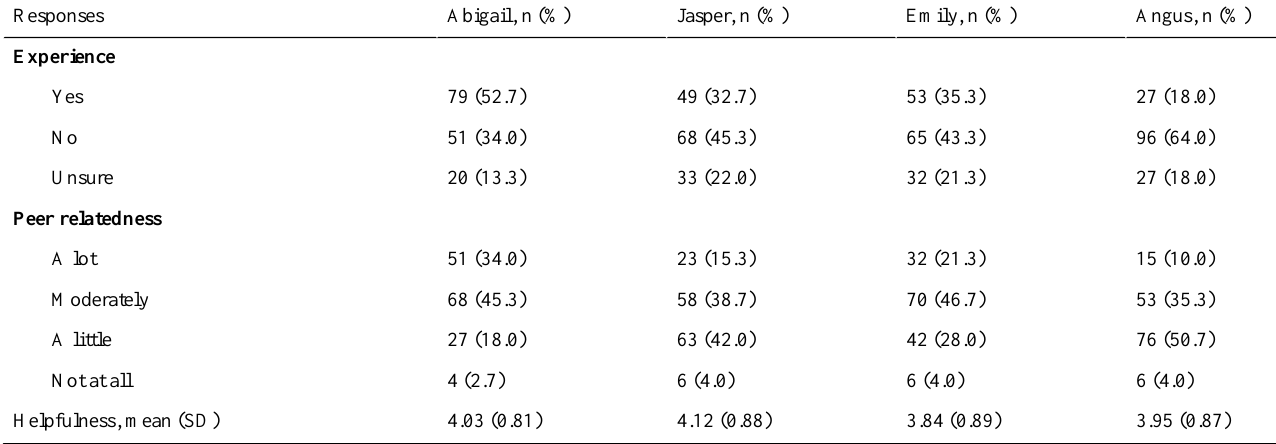
Table 5. Participant responses to the vignettes